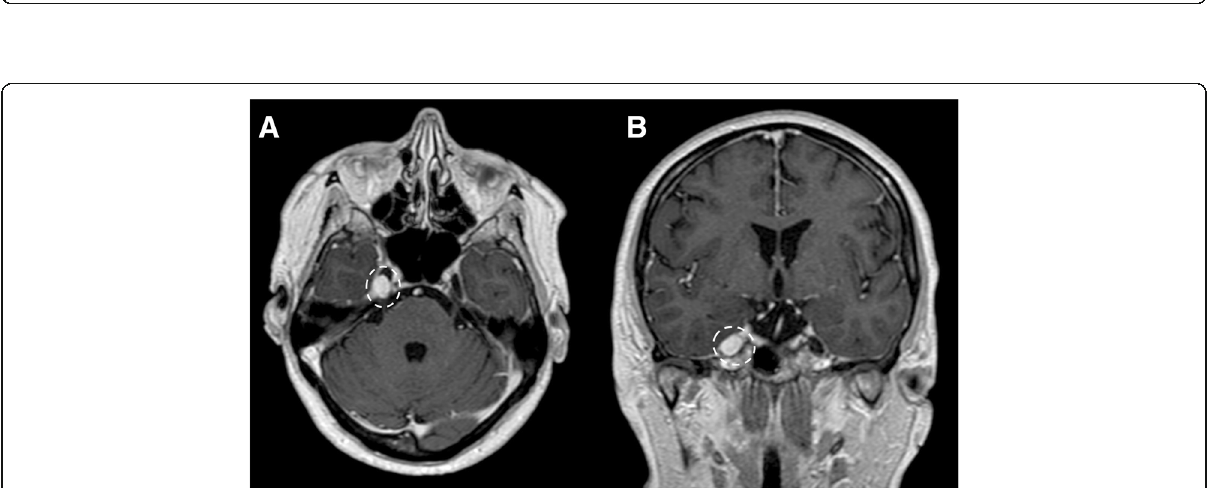
Fig. 11 Small intracanalicular vestibulocochlear schwannoma. MRI steady-state free procession (SSFP) ( a ) and T1-weighted post-gadolinium ( b ) axial images show a small hypointense lesion on steady-state sequence with avid contrast-enhancement visible in the intracanalicular segment of internal auditory canal (arrows)